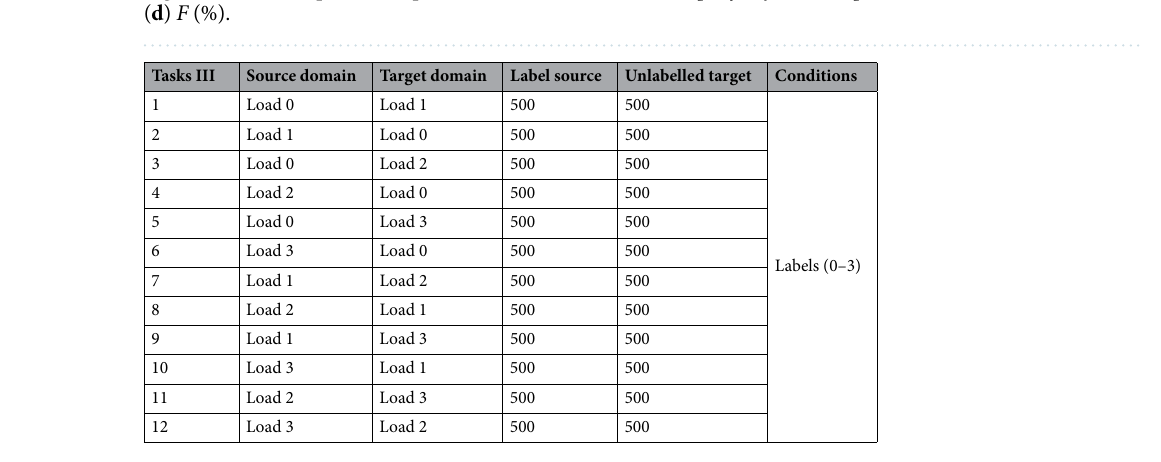
Table 5. Designed transfer tasks across different motor